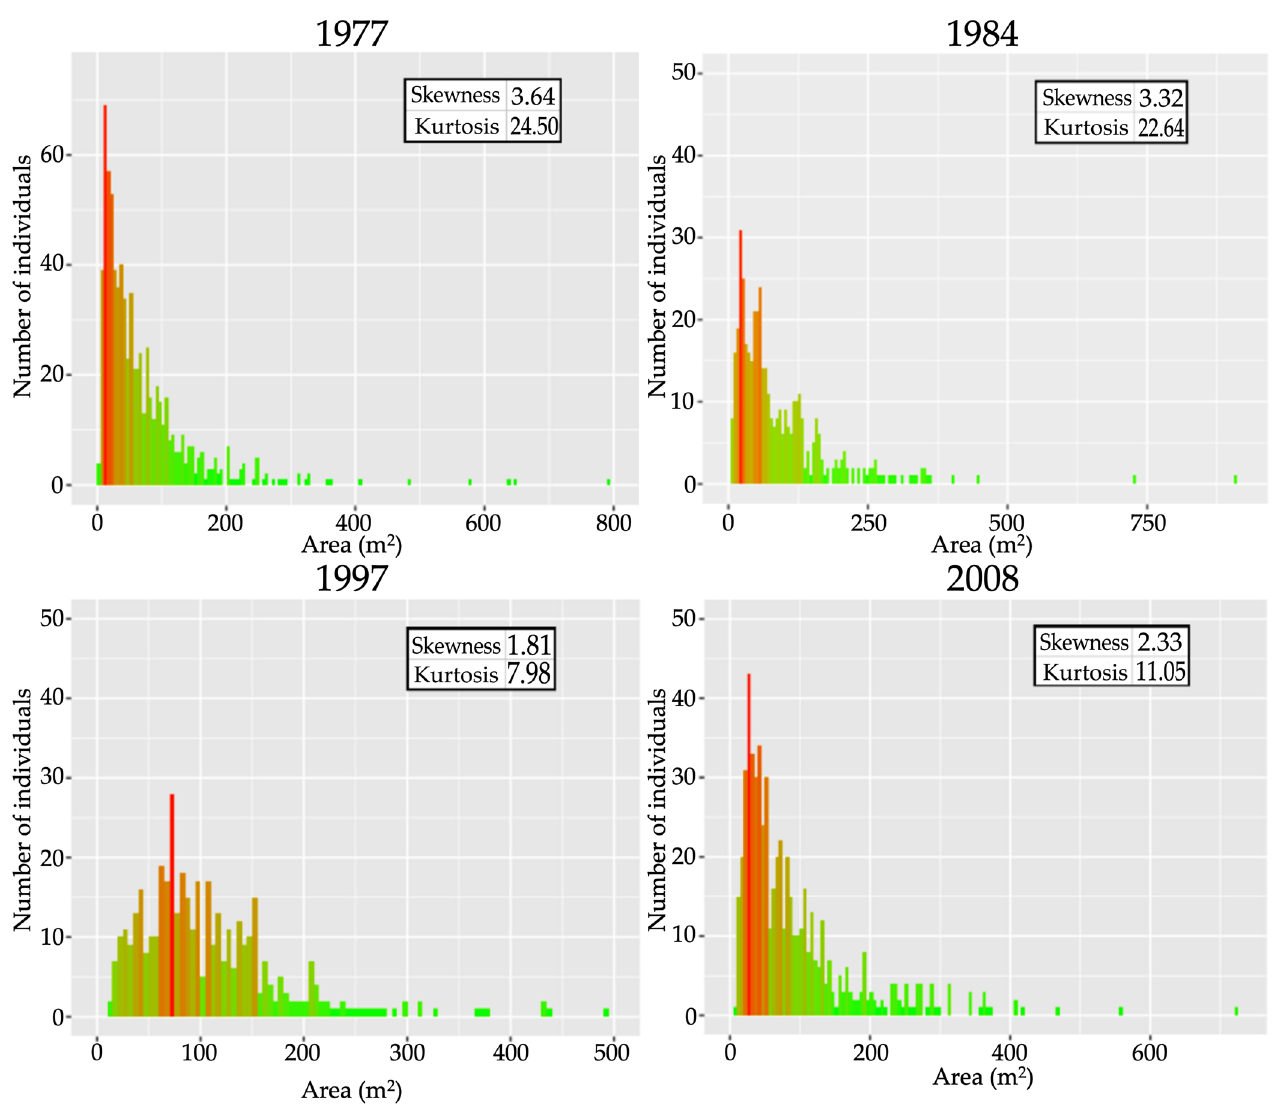
Figure 5. Distribution of population sizes of Juniperus communis L. individuals according to their canopy area during the four years studied. Skewness values greater than one show distributions skewed toward the smallest sizes. Kurtosis values greater than one show the non-uniformity of the distributions. The distributions of the four dates studied appear skewed toward smaller population sizes. None of the populations studied appear uniformly distributed in size.